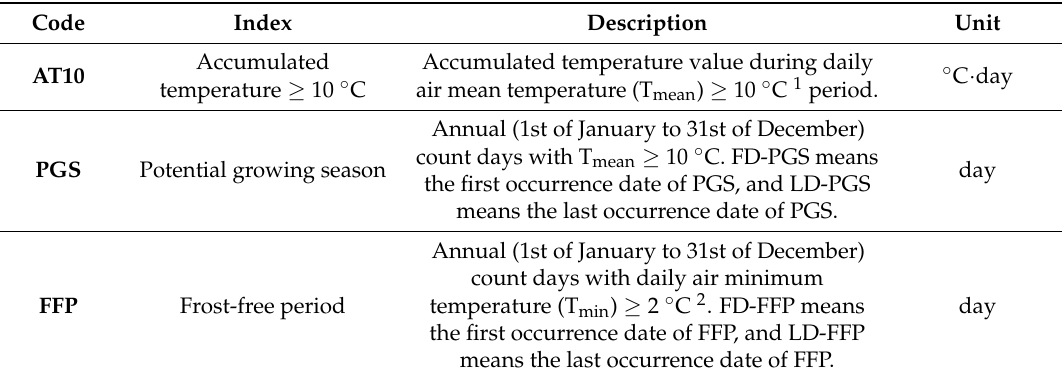
Table 1. Definitions of thermal indices used in this